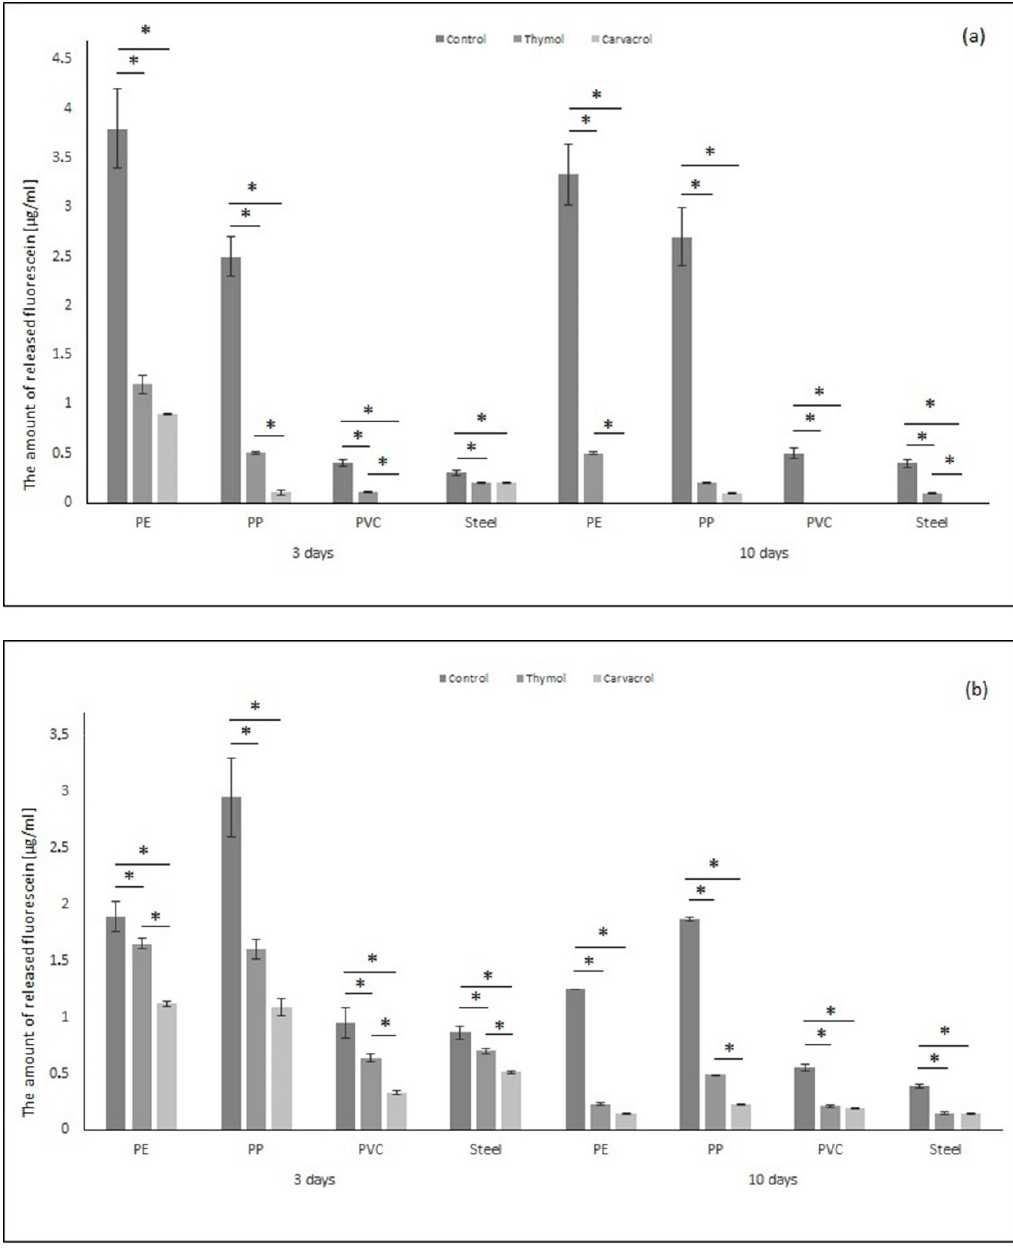
Figure 3. Hydrolytic activity of biofilm formed by ( a ) Pseudomonas aeruginosa and ( b ) Staphylococcus aureus on tested materials (PE, PP, PVC, stainless steel), after application of thymol and carvacrol depending on the time of exposure. All analyses were performed in triplicate. Data are presented as mean ± SD (one-way ANOVA test and Tukey test were performed to determine the statistical significance between the indicated groups (* p < 0.05)).